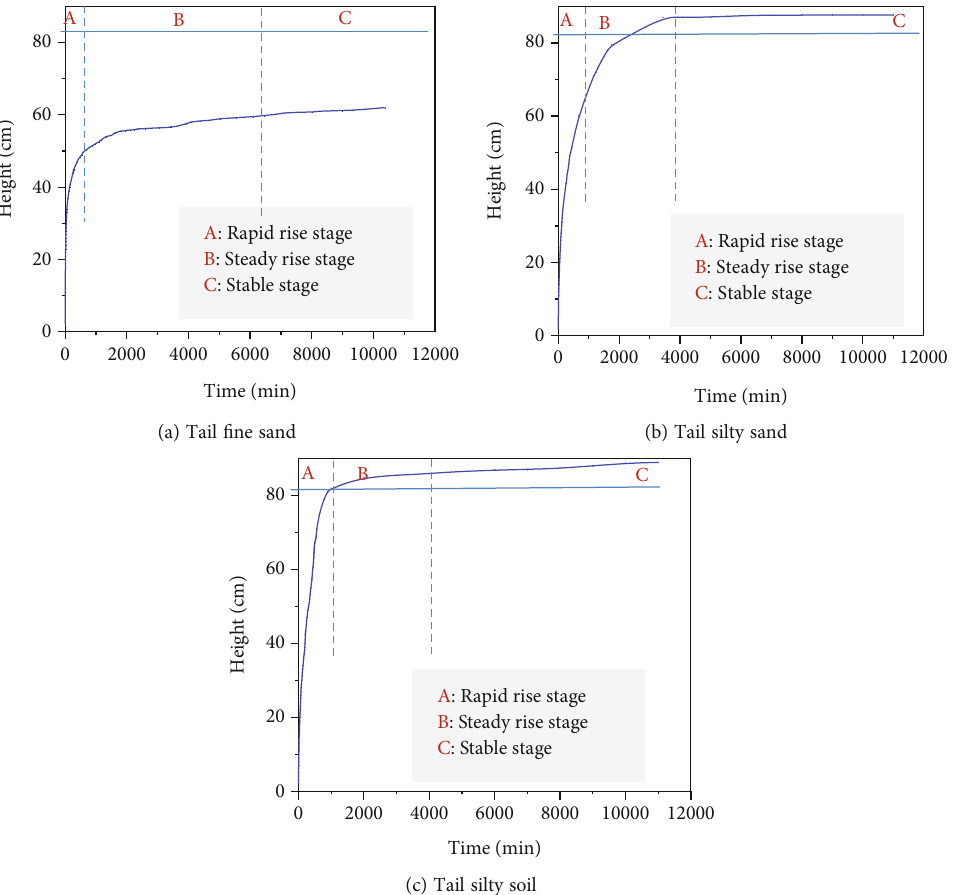
Figure 6: The relationship between capillary height and absorption time.